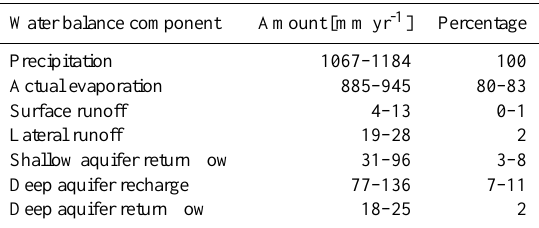
Table 2. Modelled average annual water balance of the Pangani Basin. The range indicates the 95% prediction uncertainty